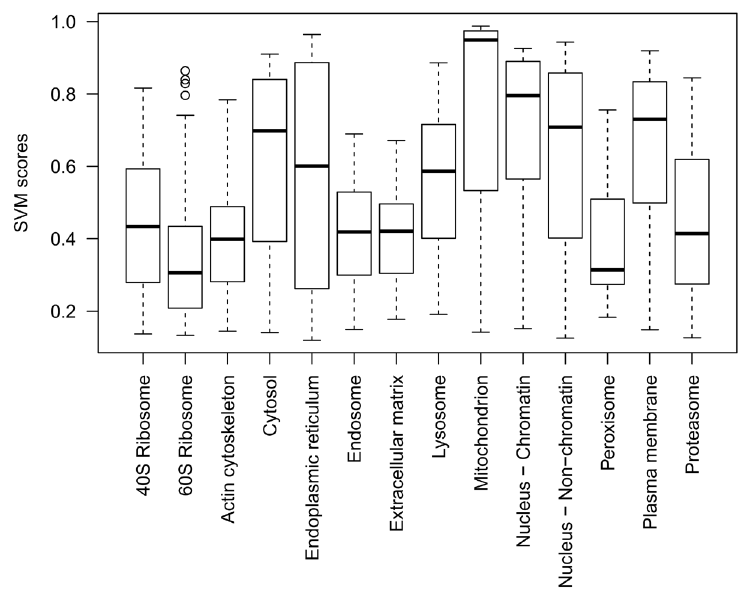
Figure 17. Visualistion of class-specific classification score